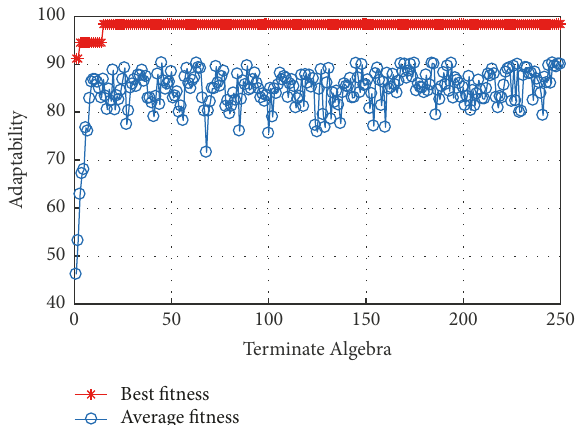
Figure 10: Fitness curve of the Genetic Algorithm.